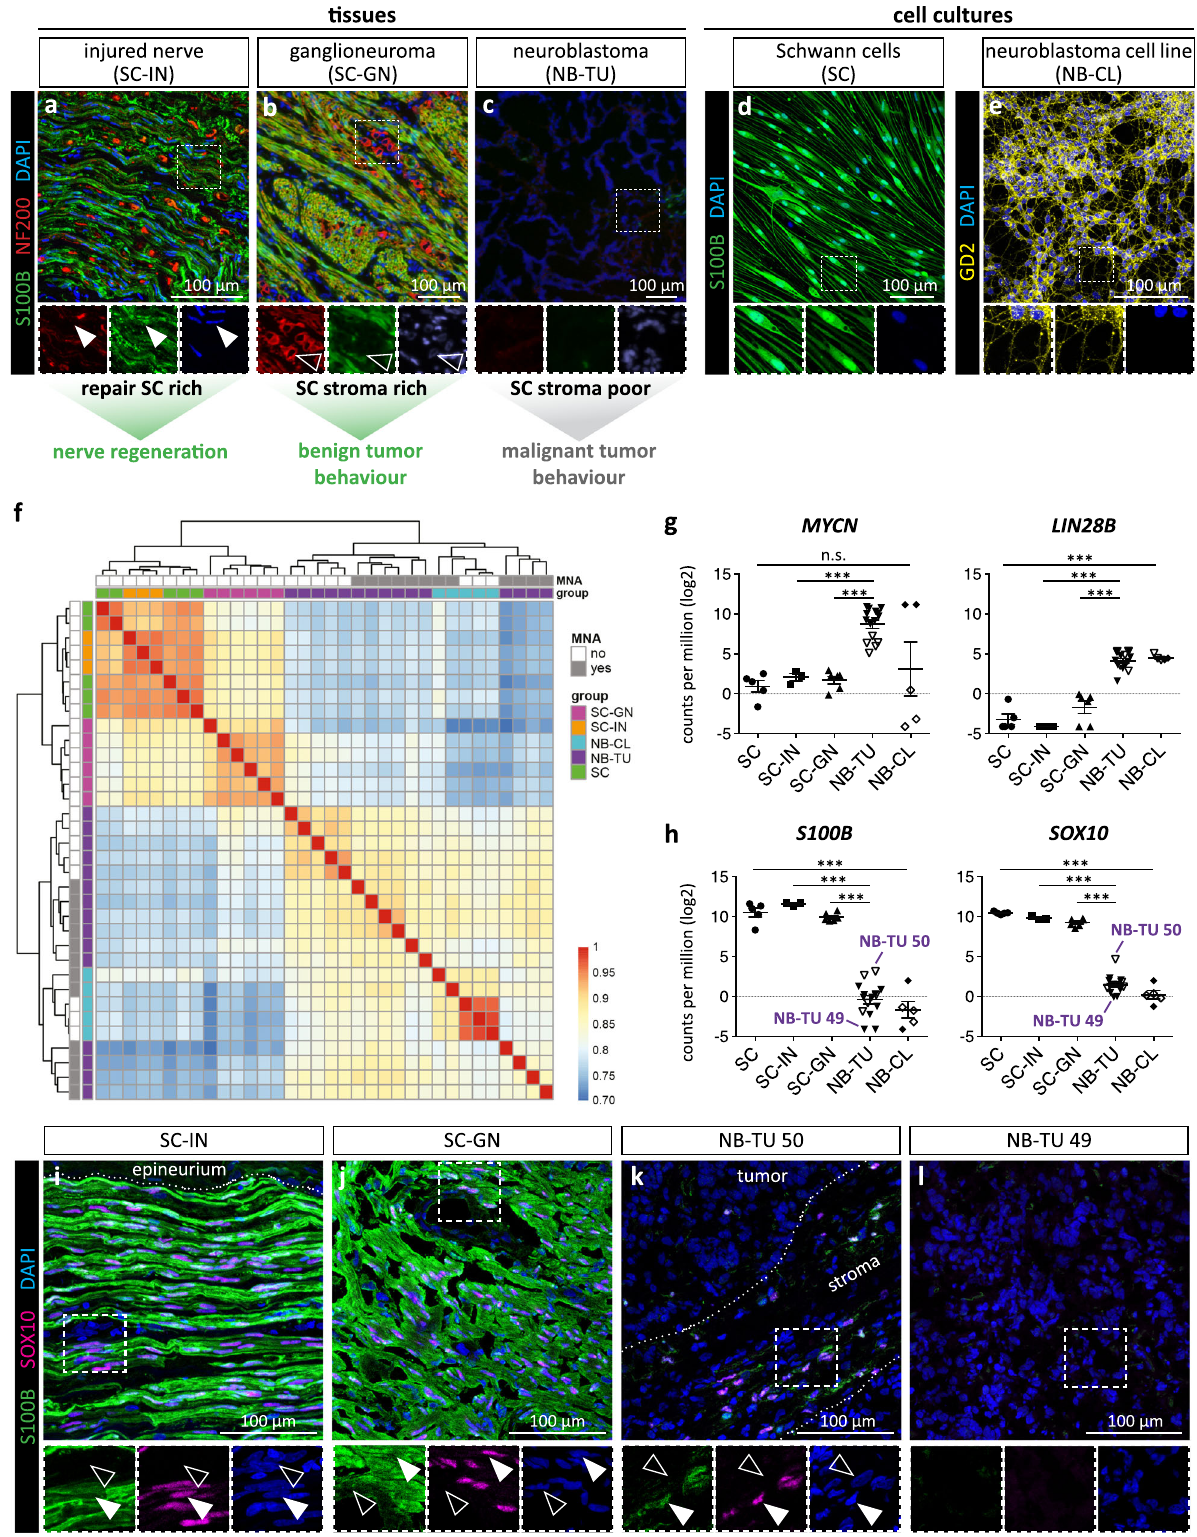
and transcription factor SOX10 10 . Indeed, expression of LIN28B was signi fi cantly higher in NBs and NB cell lines, and the MYCN expression level re fl ected the presence or absence of MYCN ampli fi cations in NB cell lines and tumors (Fig. 1g, Supplementary Table 2&3). Of note, ampli fi cation of the MYCN oncogene is associated with an aggressive NB tumor behavior and